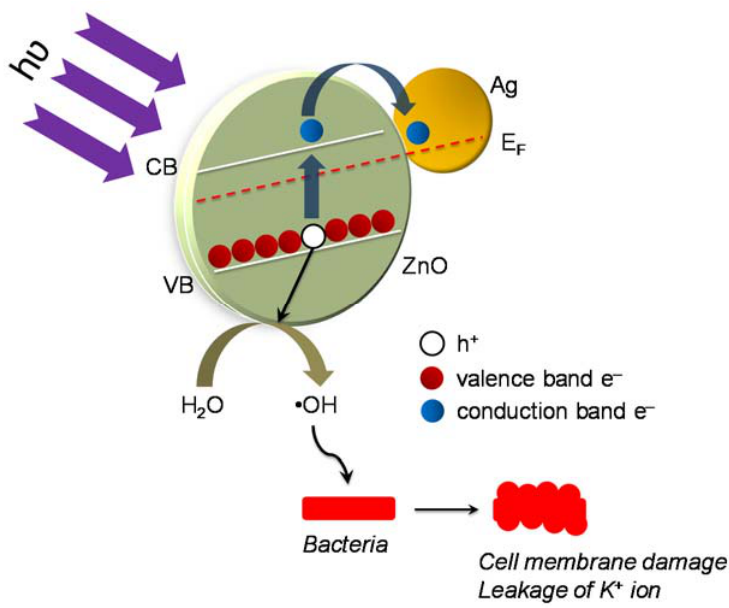
Figure 10. Proposed mechanism of sun ‐ light assisted photocatalytic disinfection of bacteria using Ag@ZnO core ‐ shell nanoparticles